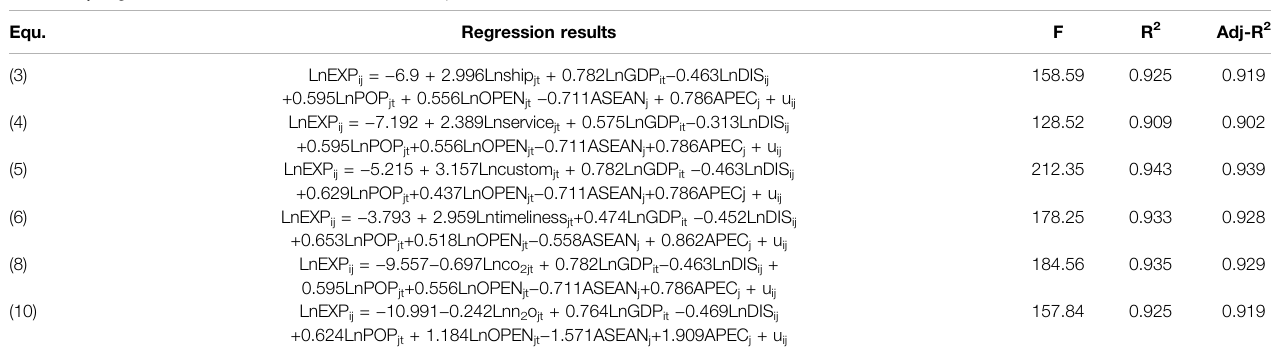
TABLE 7 | Regression of GLPI sub-indexes in RCEP sample countries. Equ. Regression results